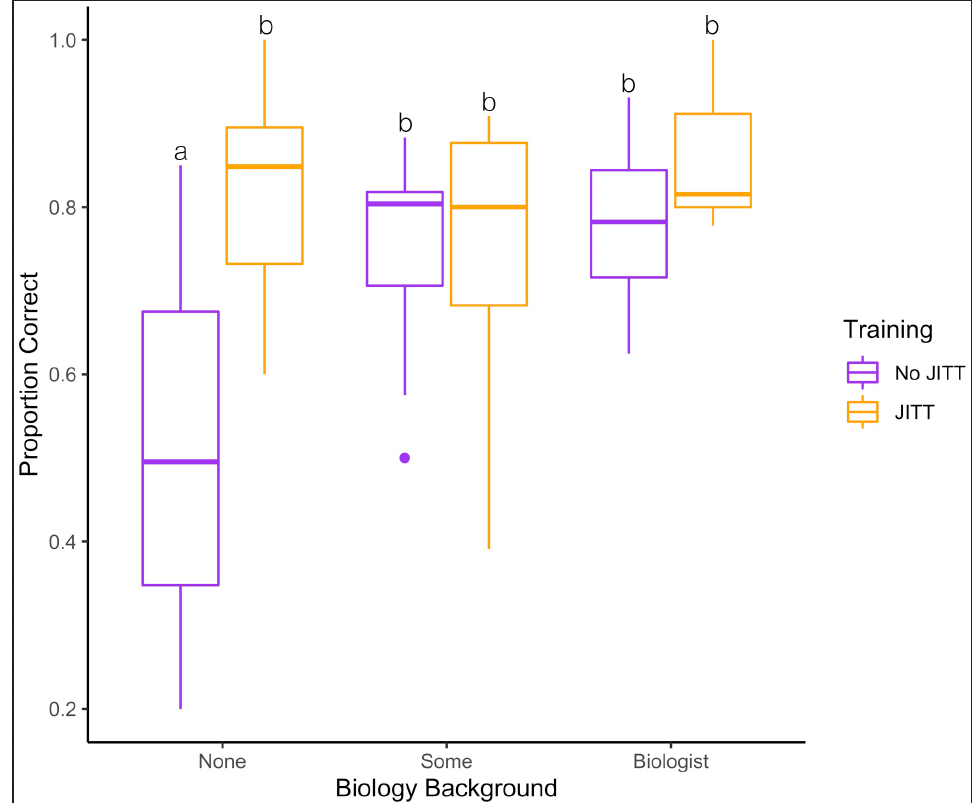
Figure 2: Accuracy of identifications (proportion of photos correctly identified) based on biology background of par- ticipants and training received. This boxplot displays the median and interquartile range for each category of biology background and treatment type (n = 91). Volunteers with no biology background were able to provide identifications that were as accurate as volunteers with biology backgrounds when training was provided but were less accurate when no training was provided (ANOVA Background by Treatment Interaction: F-ratio = 7.61, df = 2, p = 0.00091). Letters denote significance (Tukey-Kramer: p ≤